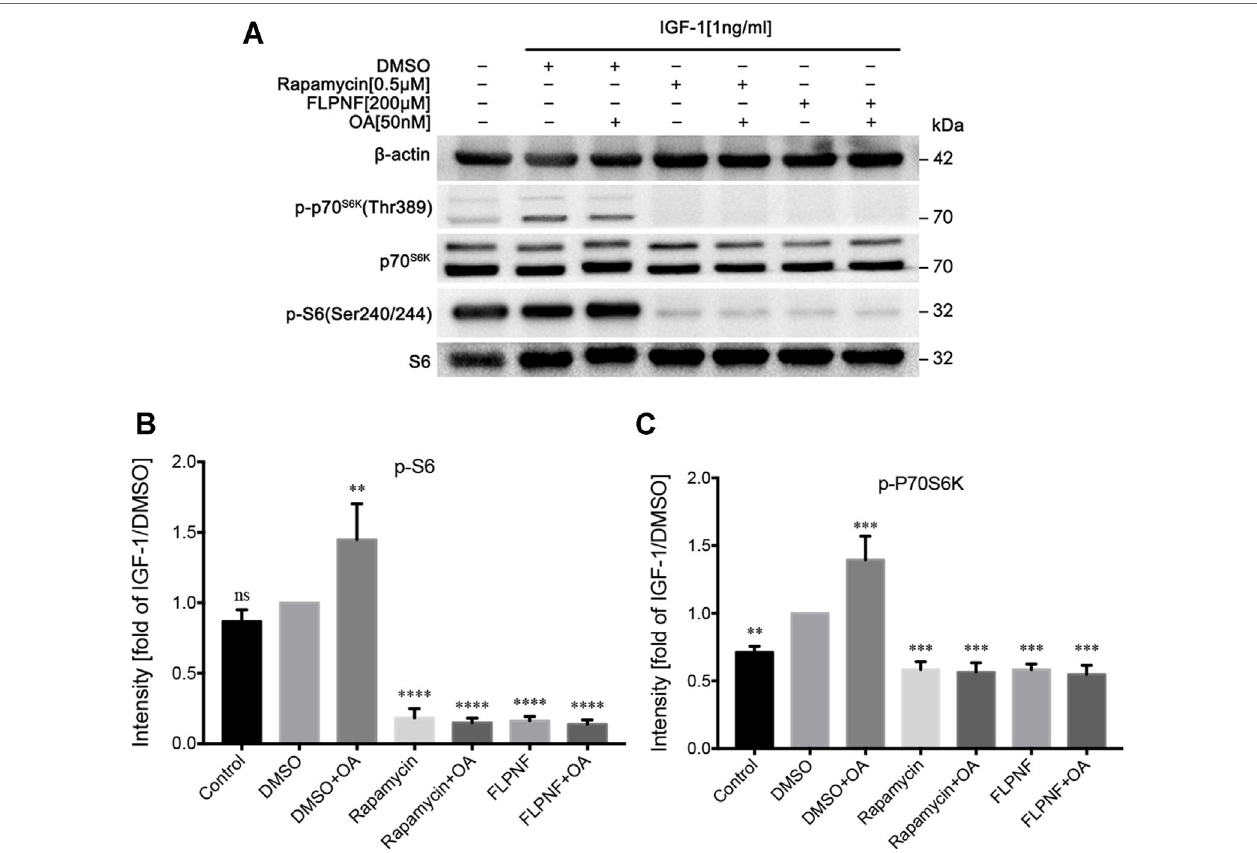
FIGURE 4 | Peptide FLPNF inhibits IGF-1-induced activation of Akt-mTOR signaling. (A) Protein levels of phosphorylated S6 and P70S6K were assessed by Western blot in hIAPP-INS-1 cells after exposure to 200 μM peptide FLPNF for 24 h. The protein phosphatase 2A inhibitor okadaic acid (50 nM) was added for the final 60 min of the incubation (lanes 3, 5, and 7) before IGF-1 (1 ng/mL) was added for 20 min. (B) and (C) The graph represents the quantification of phosphorylated S6 and P70S6K protein levels, respectively (n = 4). The band intensities were quantified and statistically analyzed relative to IGF-1/DMSO-treated cell. ** p < 0.01, *** p < 0.001, and **** p < 0.0001 vs. IGF-1/DMSO-treated